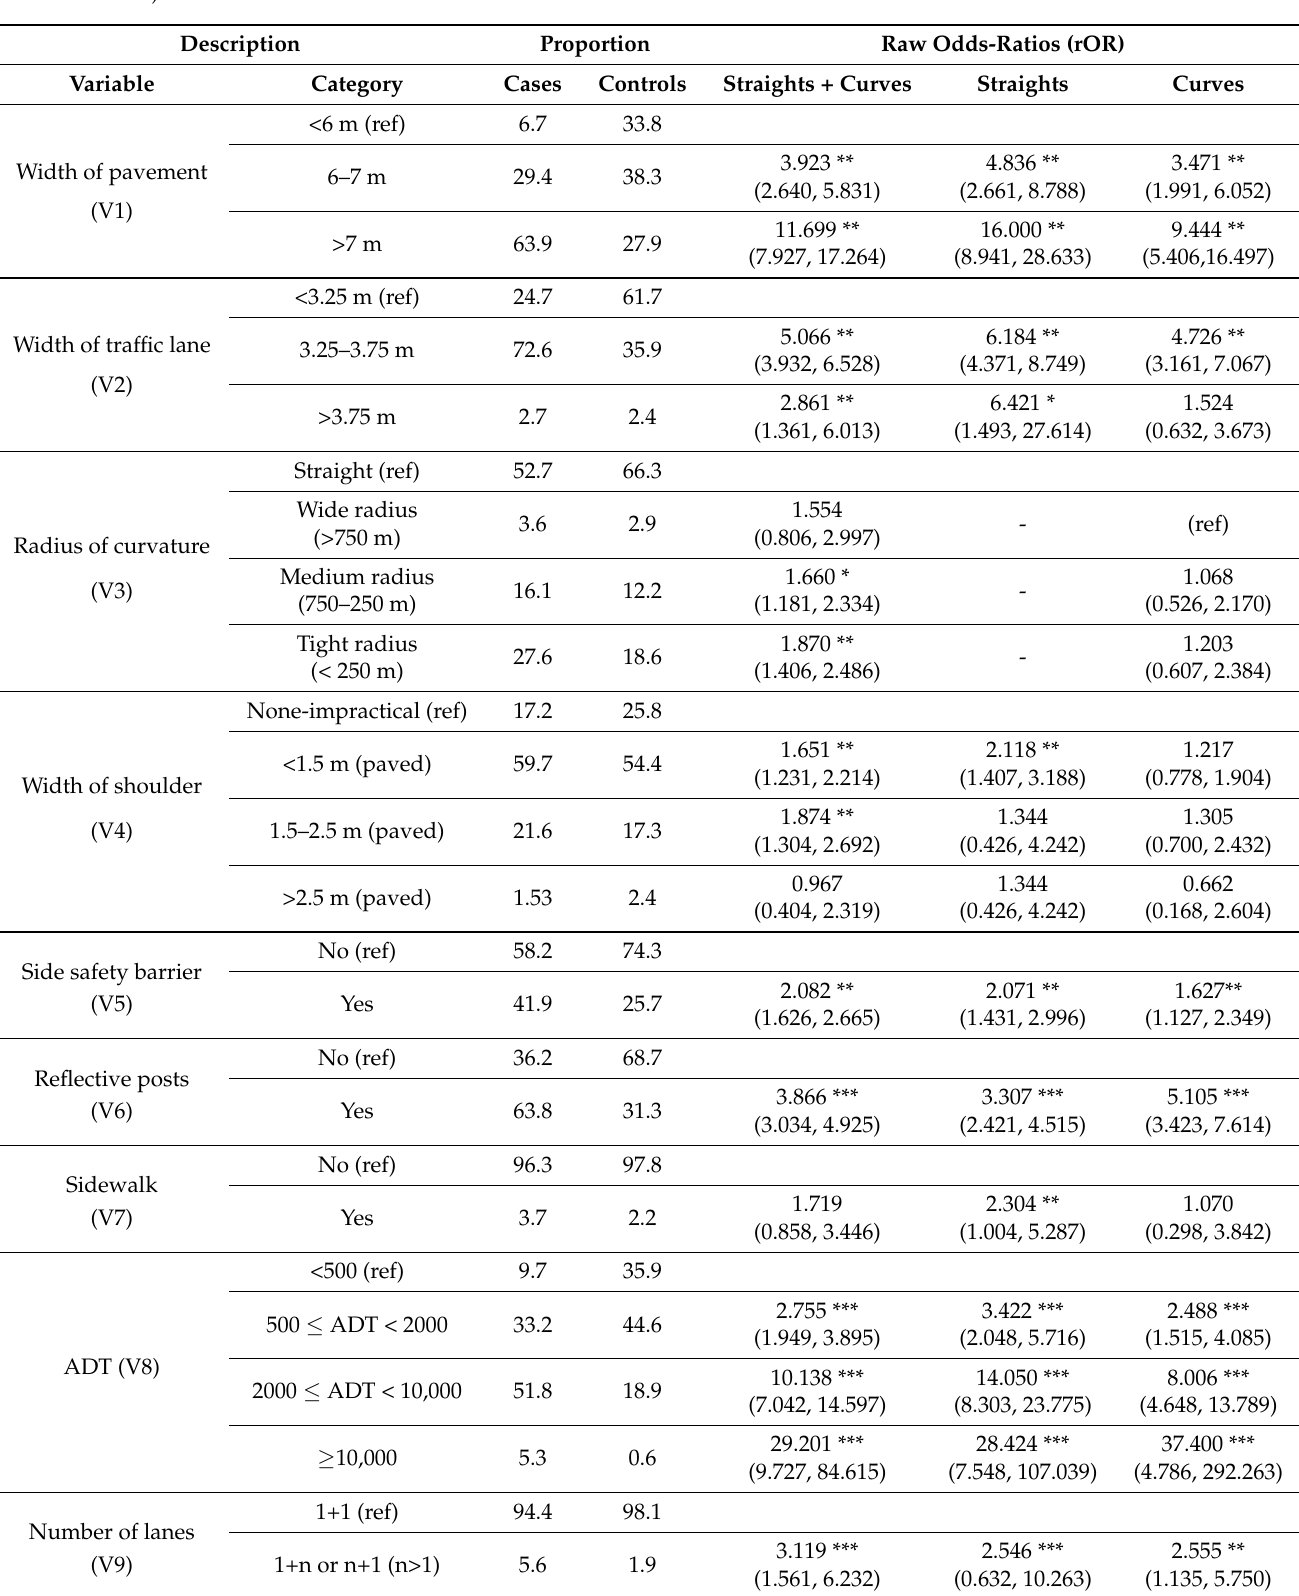
Table 2. Raw odds-ratios (rOR) and their 95% CIs for the variables considered in each of the three different scenarios, where * stands for p -value ≤ 0.1, ** for p -value ≤ 0.05 and *** for p -value ≤ 0.01. Sample size n = 588 (310 straights and 278 curves) was used for both cases and